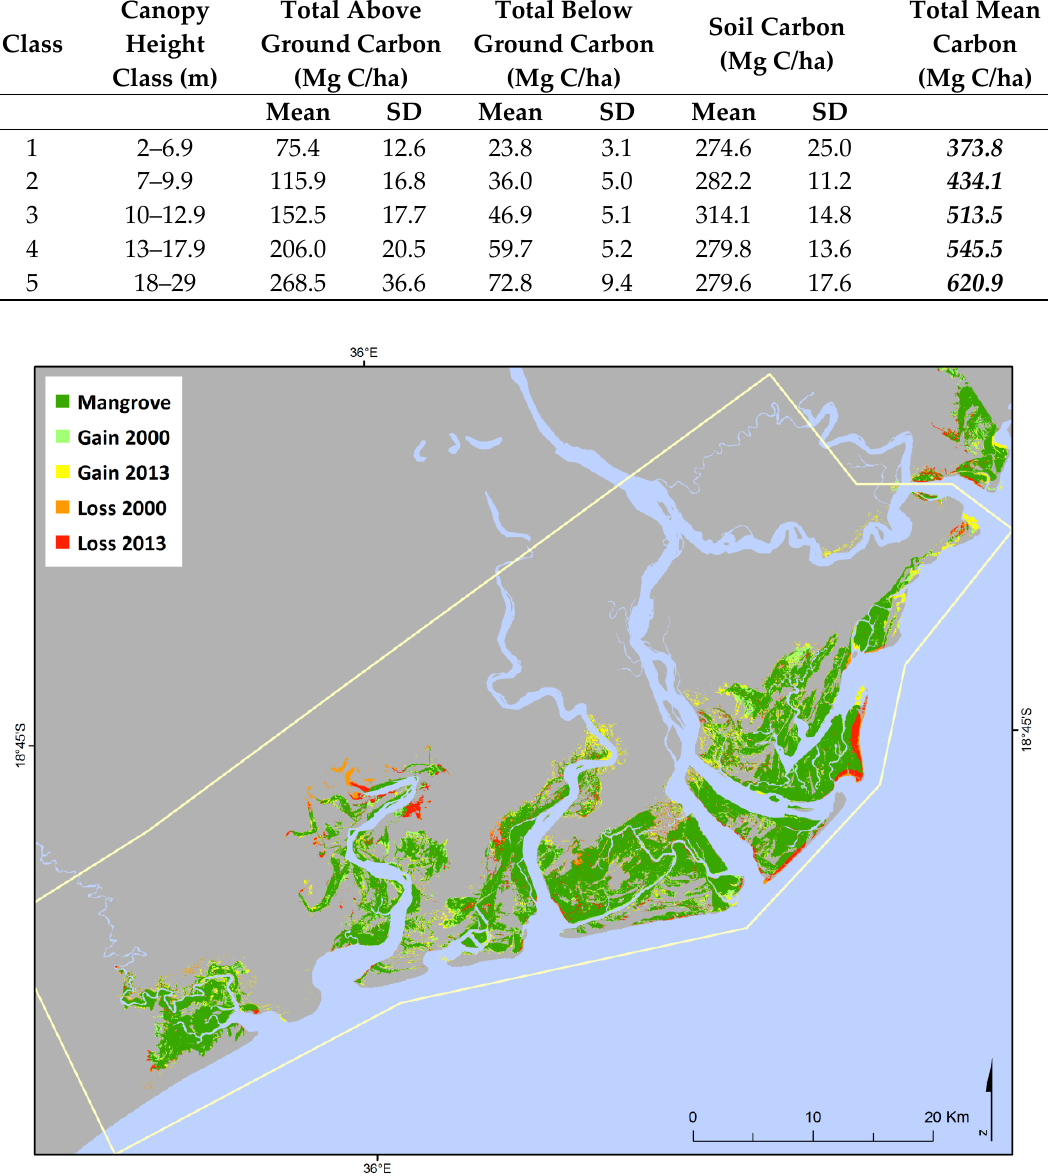
Figure 3. Change in mangrove extent within the Zambezi River Delta from 1994 to 2013 detected with Landsat